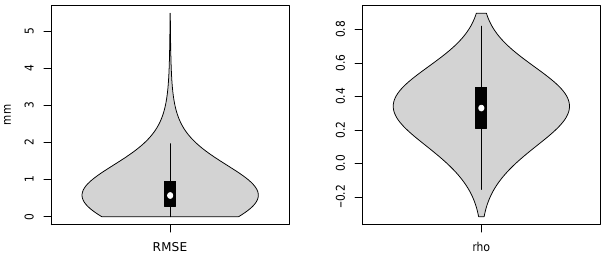
Figure 5. Validation of estimated rainfall quantities for 2013 on an hourly basis. Each of the data points is the average performance of 1h. See Fig. 3 for further information on the figure